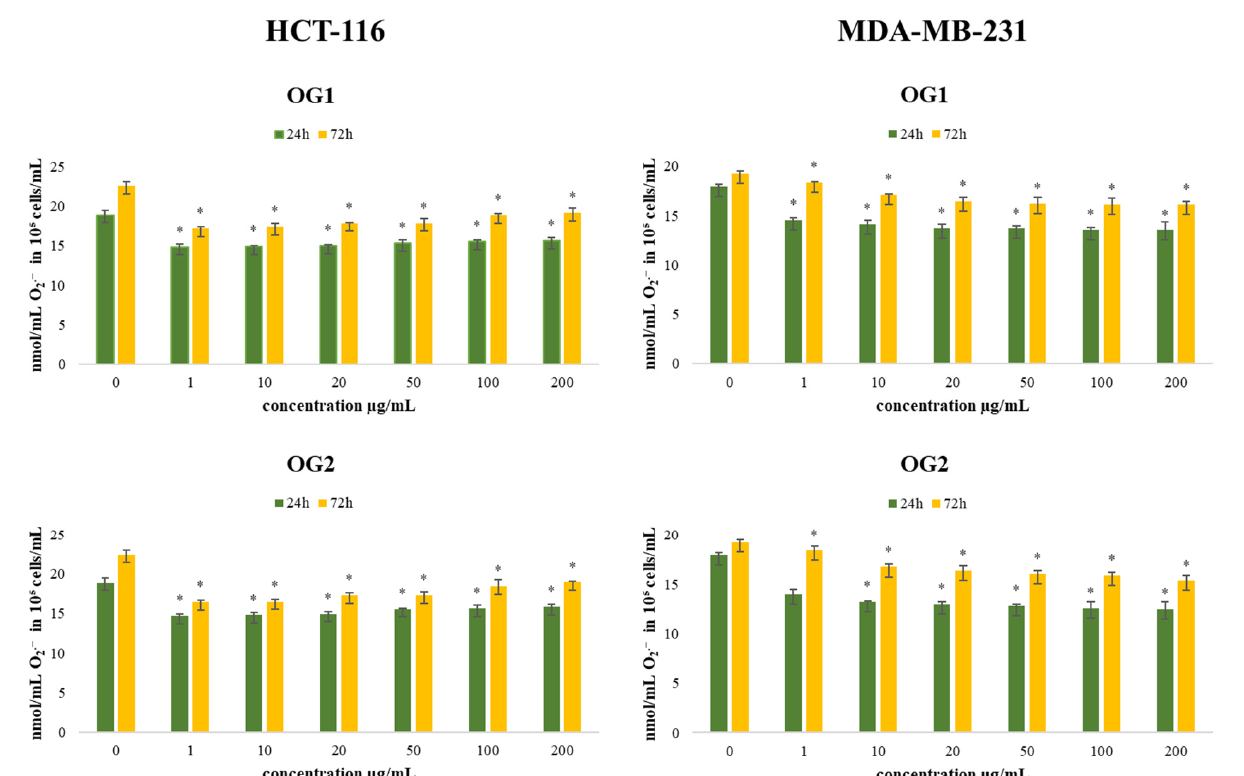
Figure 6. Effects of six concentrations of essential oils on the concentration of O 2 •− in HCT-116 and MDA-MB-231 cells after 24 and 72 h of treatment. Results are presented as the mean of three independent experiments ± standard error; * p < 0.05 relative to control.